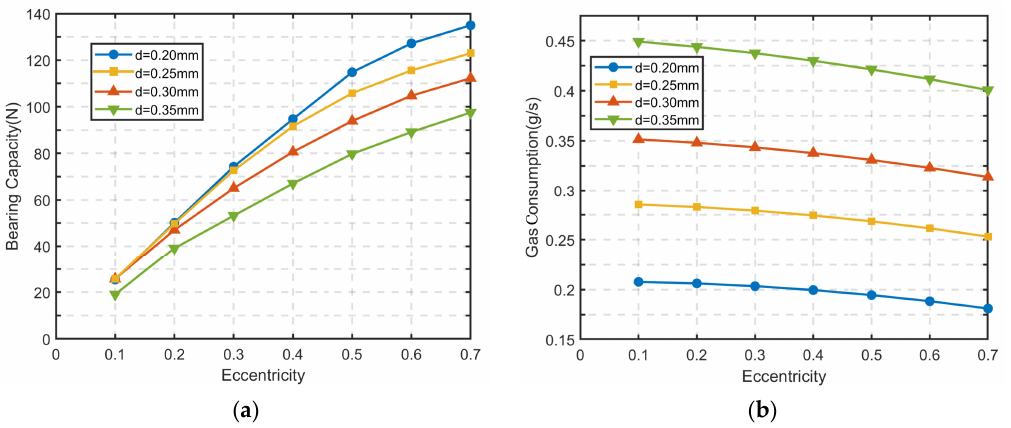
Figure 6. Influence of orifice diameter on ( a ) bearing capacity and ( b ) gas consumption.